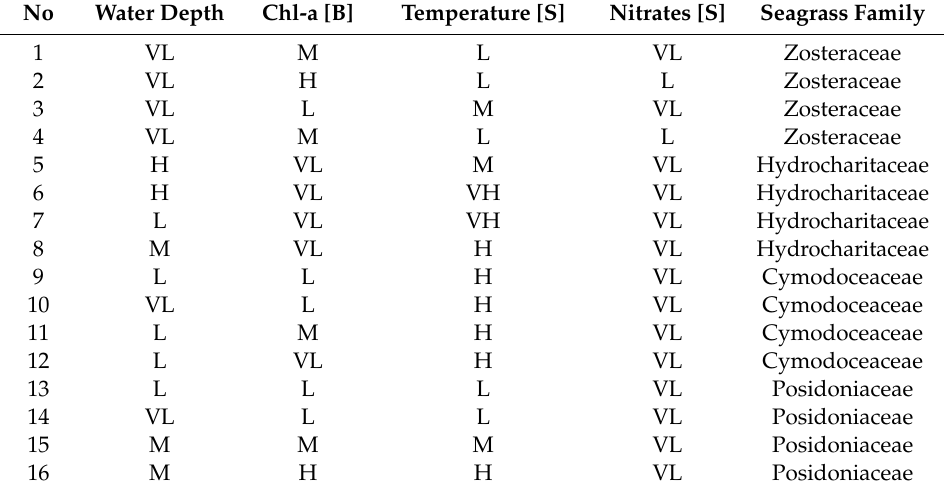
Table 5. Indicative fuzzy rules in the optimum FIS, where VL represents locations with values belonging to the Very Low fuzzy set, L in the Low, M in the Medium, H in the High, and VH in the Very High fuzzy